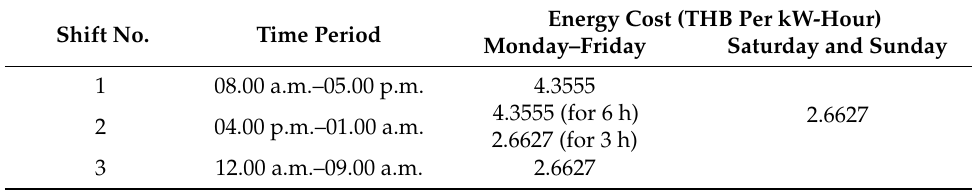
Table 4. The energy costs for each shift. Shift No. Time Period